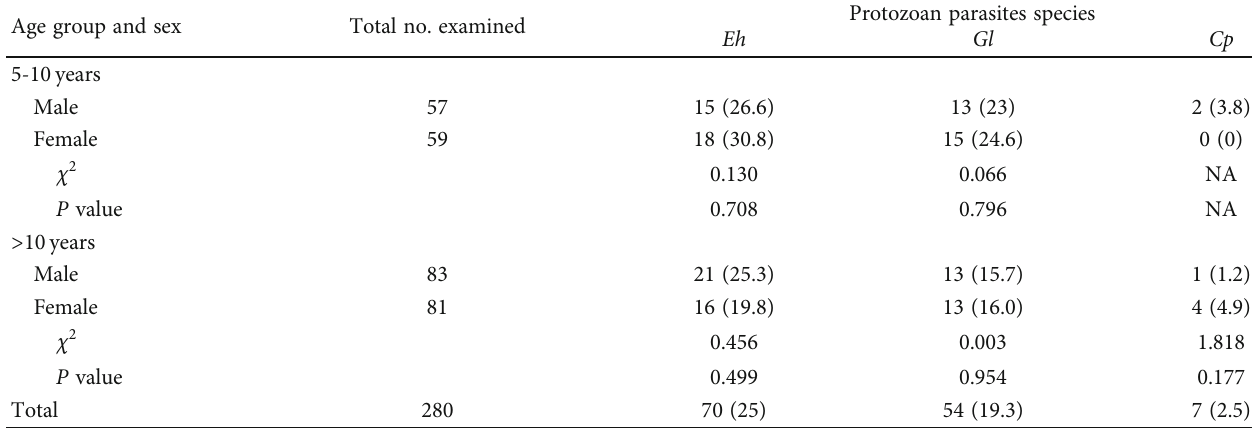
χ 2 : Chi-square. Table 3: Common intestinal protozoan parasite species identi fi ed from examined school children in Merhabete district, Amhara region, Central Ethiopia,